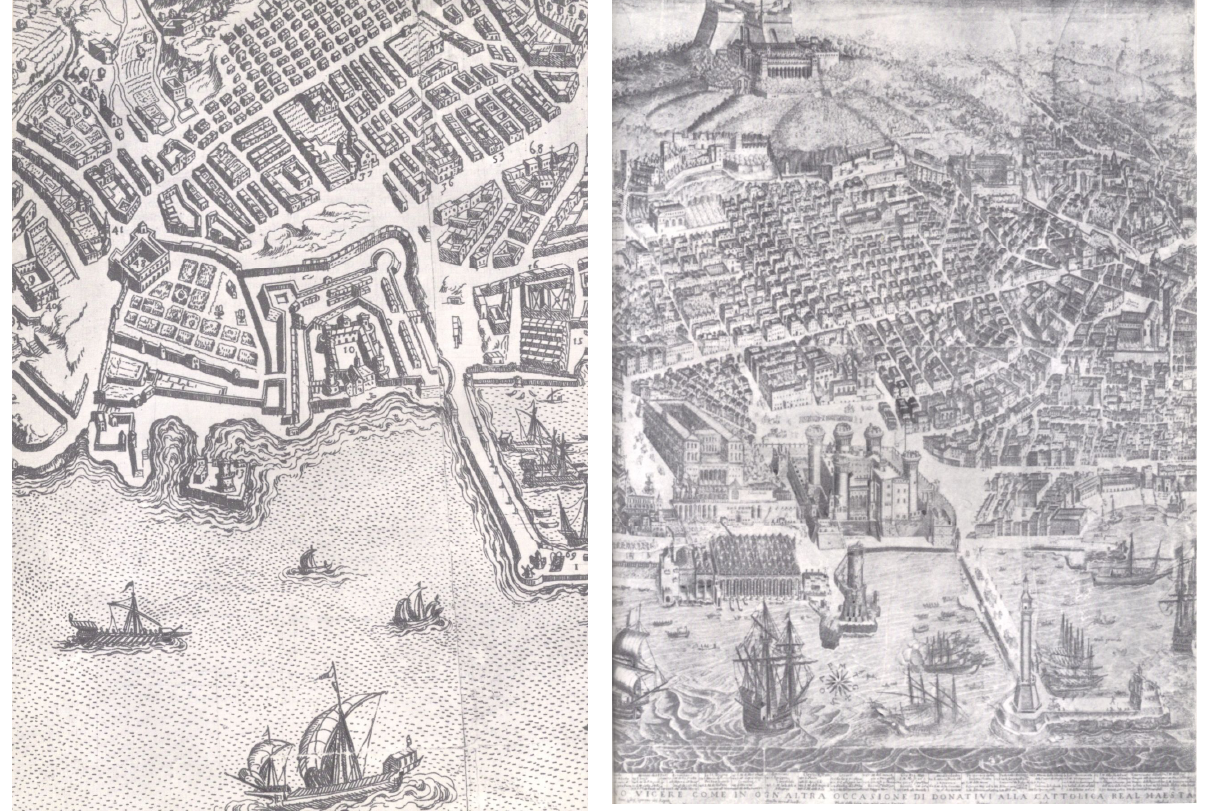
Figure 7: Lafrery 1566. Iconographic sources Figure 8: Baratta 1629. Iconographic